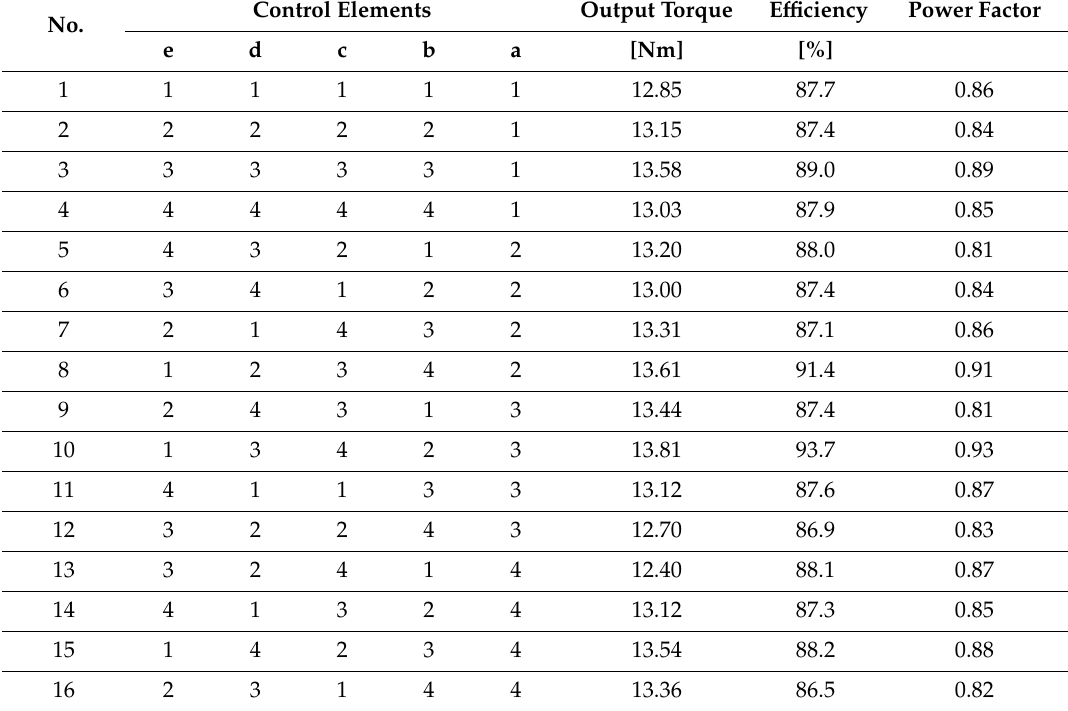
Table 4. Orthogonal array L16 matrix by the Taguchi method and performance tests. Control No.